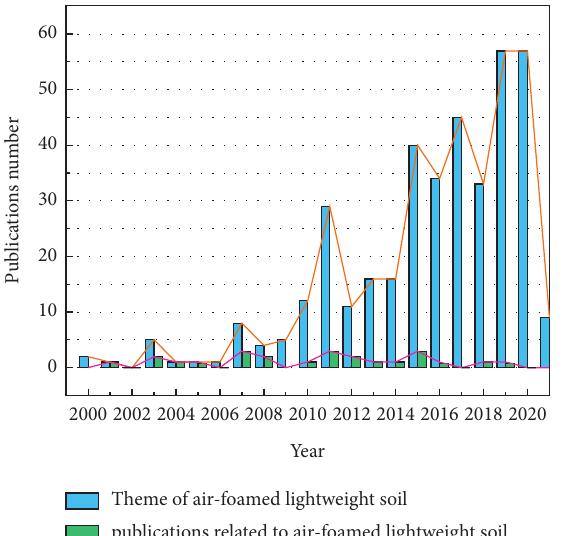
Figure 1: Numbers of research papers by year (as of April 9, 2021) based on online databases in Web of Science.